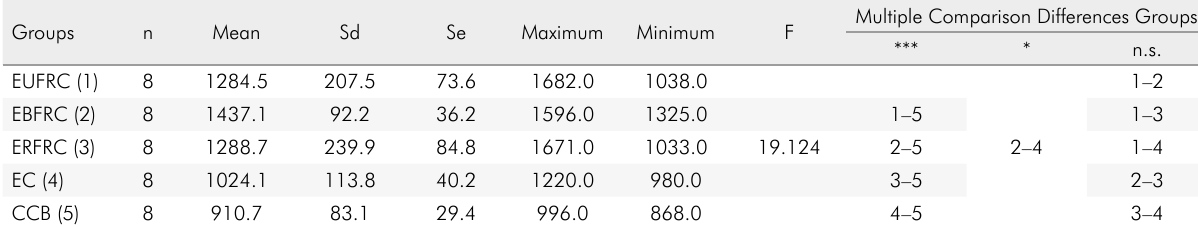
Table. Descriptive statistics for groups and multiple comparison of final failure with real P values for all groups according to ANOVA.